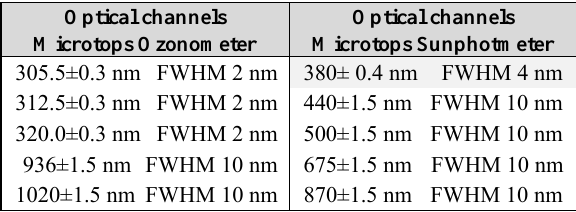
Table 1. Channel specifications of Microtops instruments